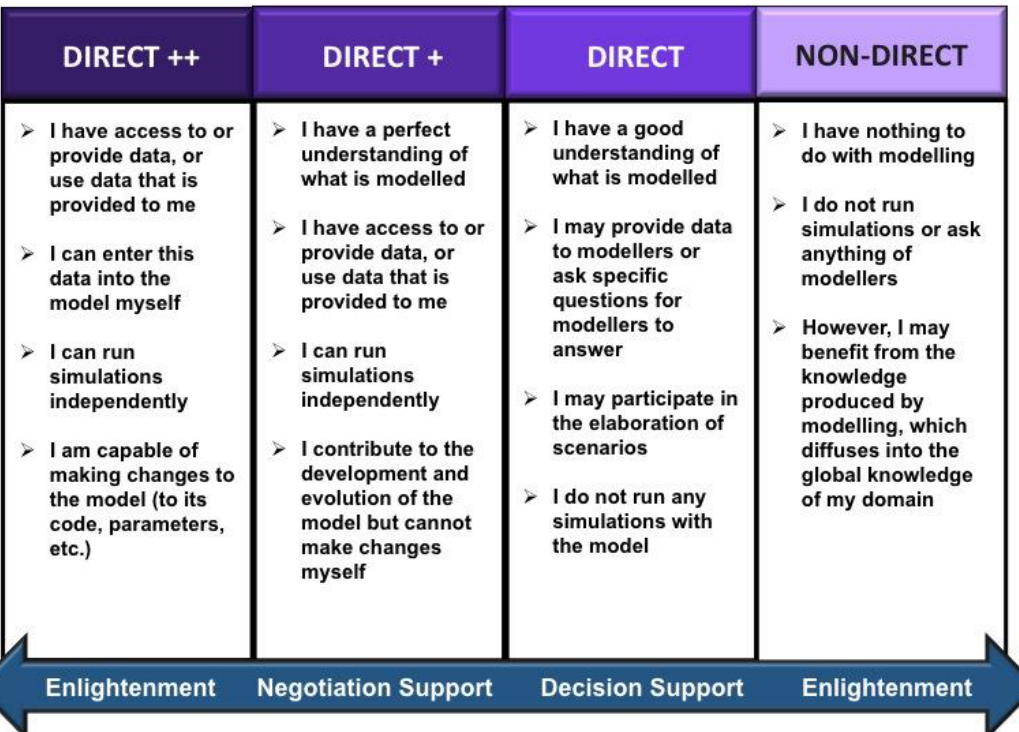
Figure 1. General Framework for Use and Utility Integrating User Involvement.